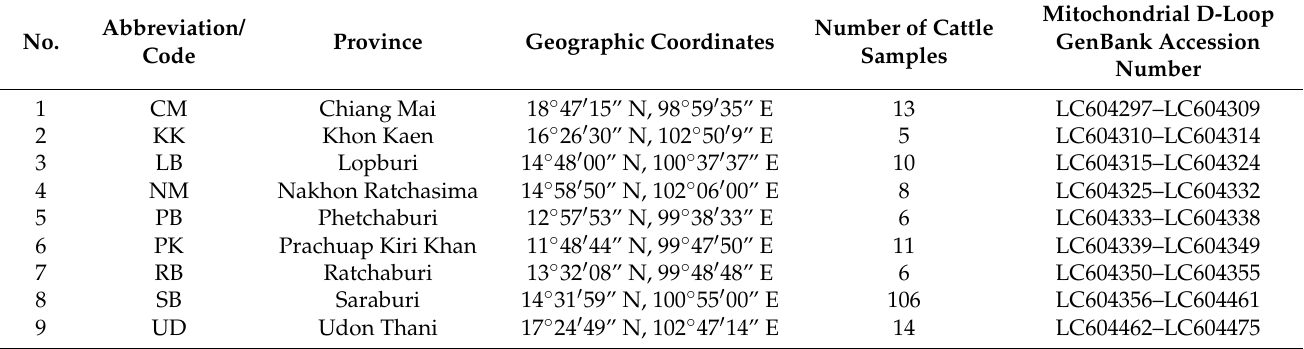
Table 1. Sampled populations of cattle ( Bos taurus ) in nine provinces of